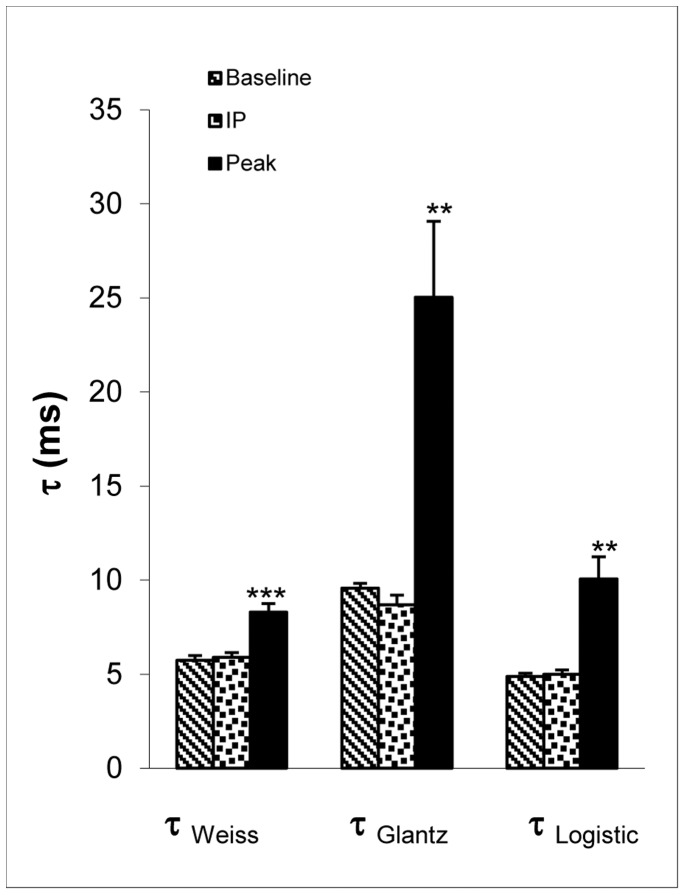
Tau at baseline, inflection point (IP), and at peak effect of phenylephrine.**: p<0.01; ***: p<0.001, self-paired t-test of black bar versus texture bar or dotted bar in the same category. IP: inflection point.